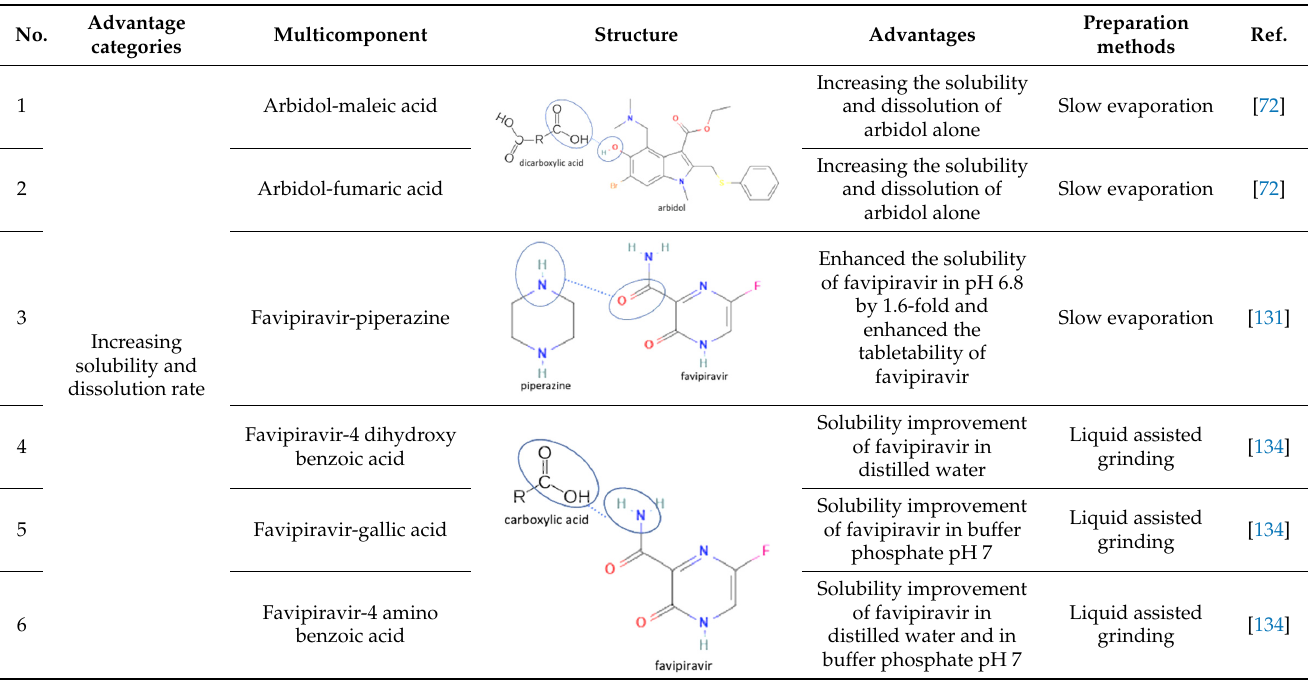
Table 2. Antiviral Multicomponent Systems.